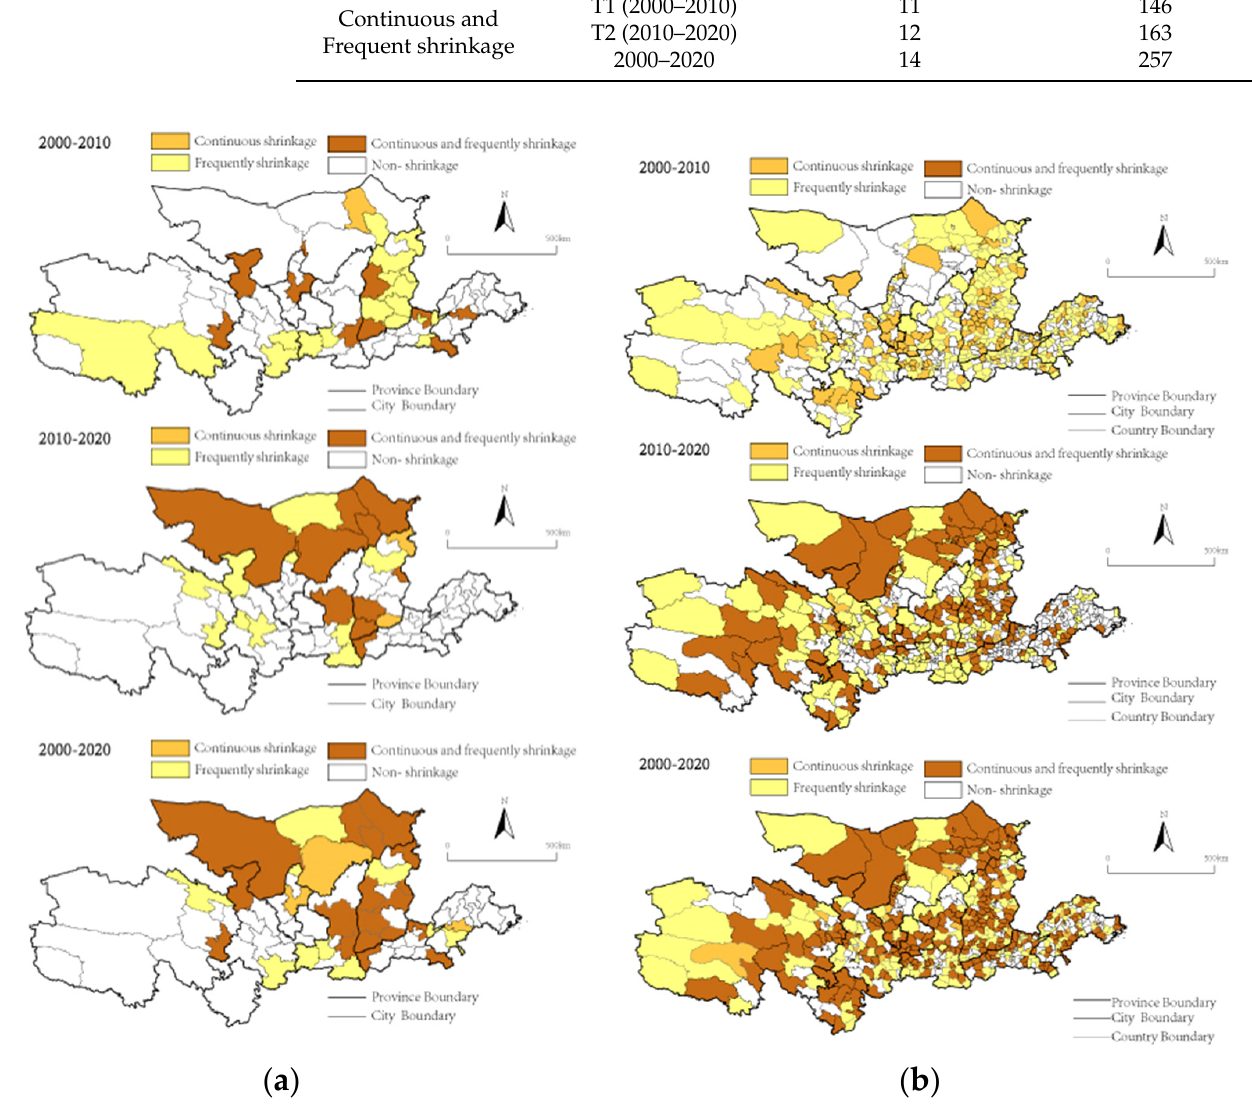
Figure 3. Shrinkage patterns during different time spans in Yellow River Basin under the night light dimension: ( a ) shrinkage patterns at the city scale; ( b ) shrinkage patterns at the district scale. In 2000–2020, 446 districts, accounting for 75% of all districts, experienced frequent nighttime light shrinkage. The number of shrinking cities doubled in T2, showing a face- to-face distribution in the upper and middle reaches. In general, the Yellow River Basin shows overall shrinkage at the district and county levels that extends from the upper and middle reaches to the eastern part of the lower